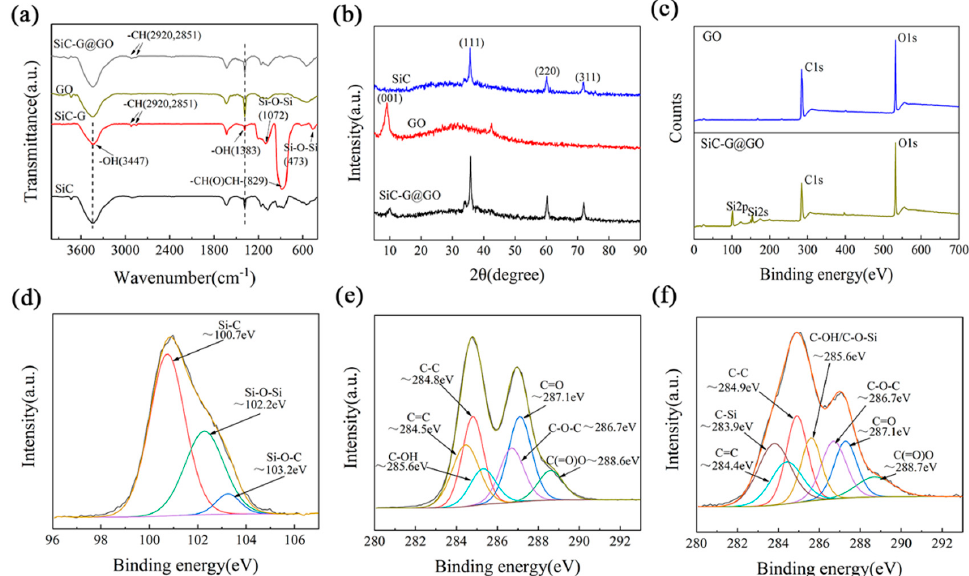
Figure 6. ( a ) FT-IR patterns of the SiC, GO, SiC-G, and SiC-G@GO samples; ( b ) XRD patterns of thw SiC, GO, and SiC-G@GO samples; ( c – f ) XPS spectra and fitting results of the GO and SiC-G@GO samples; ( c ) XPS full–scan spectra of the GO and SiC-G@GO composites; ( d ) SiC-G@GO SiC2p high-resolution spectrum; ( e ) SiC-G C1s high-resolution spectrum; and ( f ) SiC-G@GO composite C1s high-resolution spectrum.